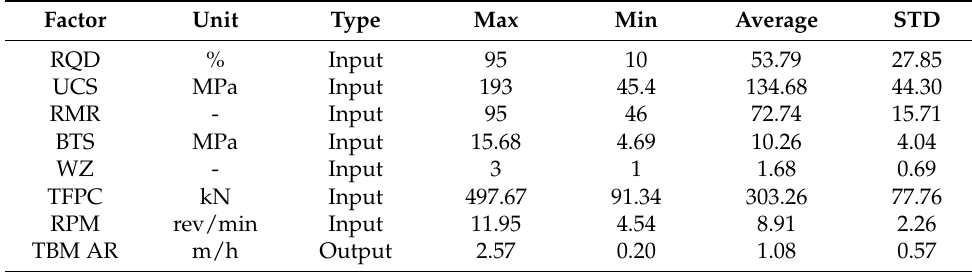
Table 1. Characteristics of the system inputs and output in this investigation.